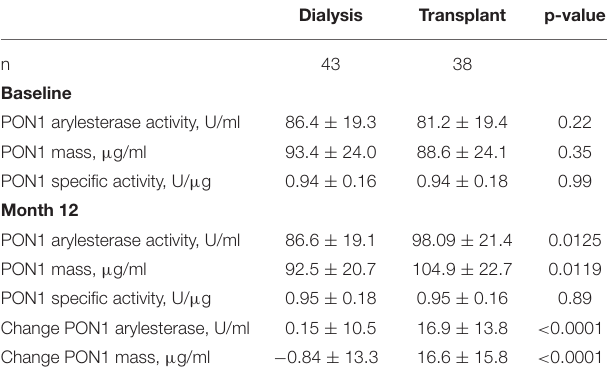
TABLE 2 | Paraoxonase 1 mass and activity by treatment